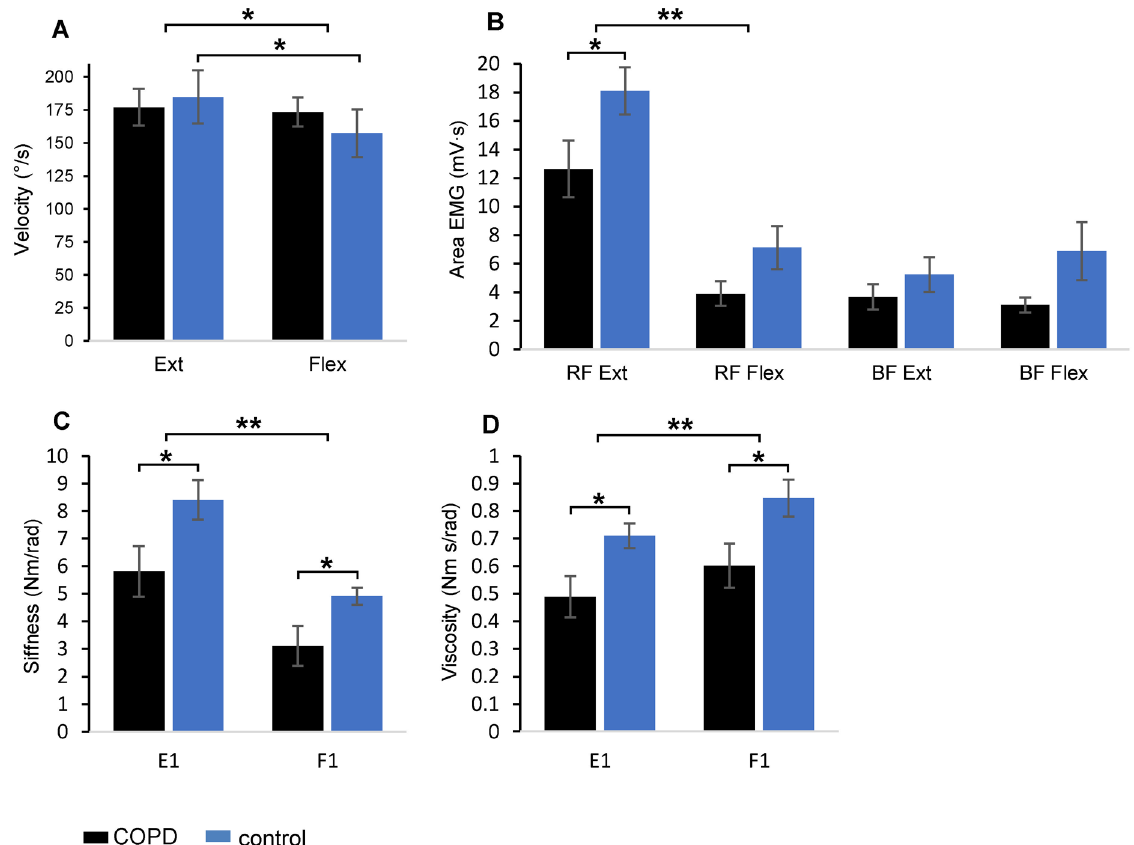
Figure 5. Comparisons between data from the active and passive protocols. The average values of movement velocity ( A ) and EMG area of Rectus Femoris and Biceps Femoris ( B ), computed over the six extension and the six flexion active movements, acquired in COPD (black) and control (blue) groups. Values of stiffness ( C ) and viscosity ( D ) during the first passive flexion and extension of the pendulum test. Abbreviations: Ext , active extensions; Flex , active flexions, RF , Rectus Femoris, BF , Biceps Femoris, F1 , the first passive flexion, E1 , the first passive extension. Symbols as in Fig.